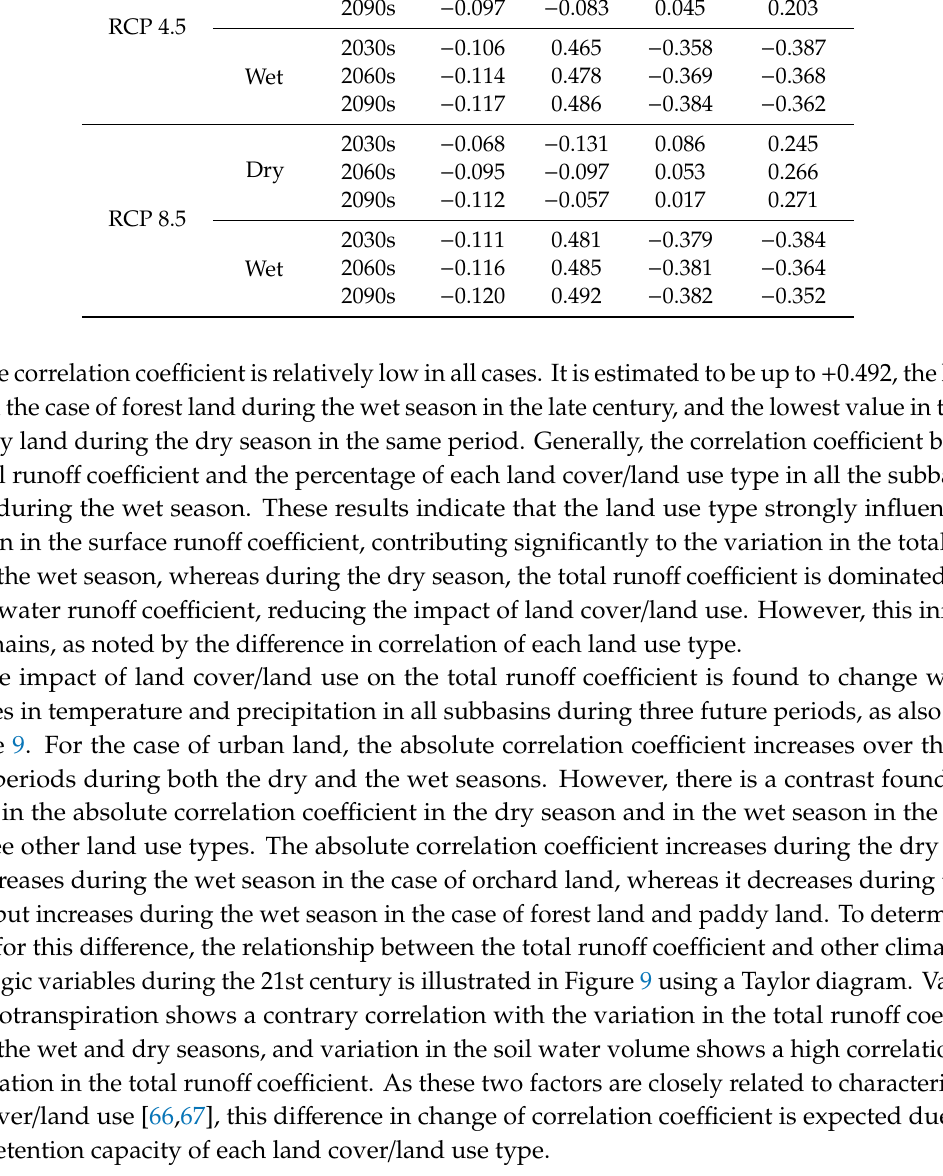
Table 9. Correlation coe ffi cient of the total runo ff coe ffi cient and percentage of each land use type. Scenario Season Period Urban Forest Paddy Orchard 2030s Dry RCP 4.5